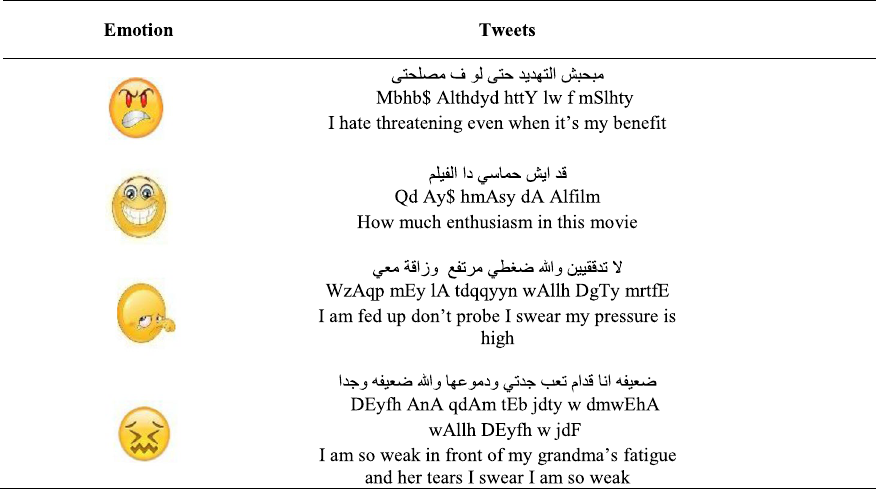
Table 1 Corresponding emotion reflection in